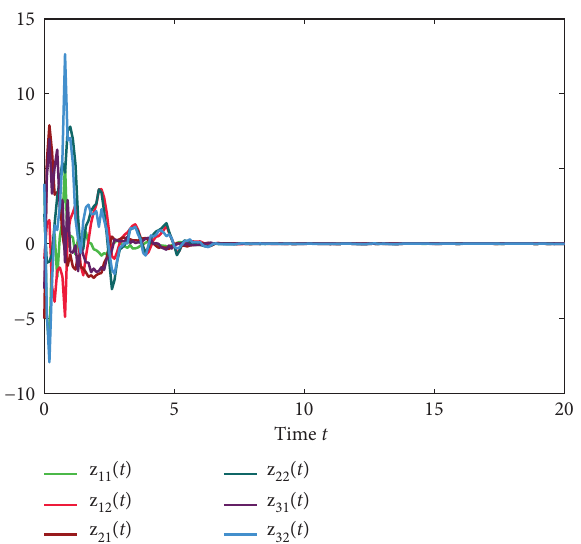
Figure 1: Trajectories of error system (5) with control inputs.